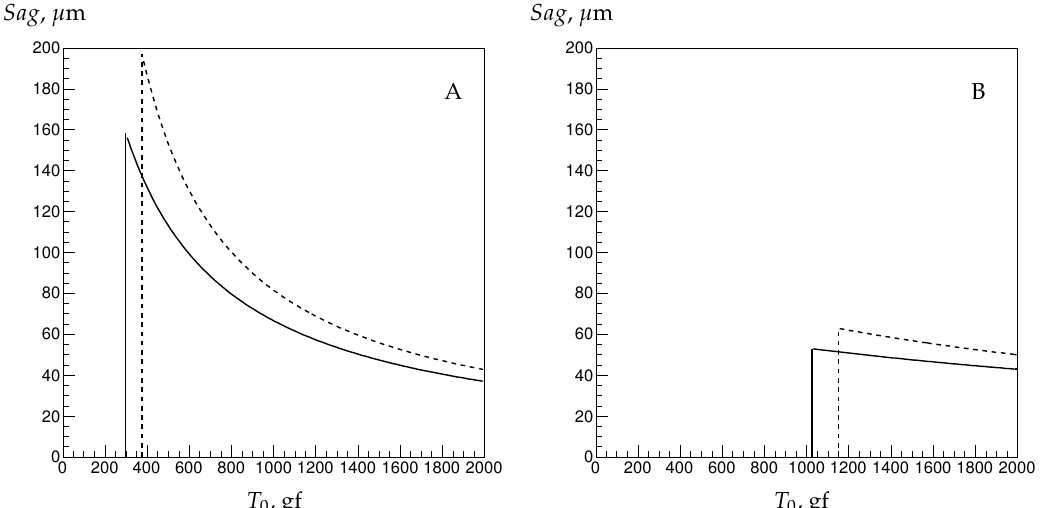
Figure 4. Sagitta in vacuum Sag versus pre-tension T 0 of 70-cm-long straw segment for: 9.8-mm straw ( A ); and 18-mm straw ( B ). Vertical lines mark the buckling limit T P = 0. Solid line is calculated for the central values for all parameters. Dashed lines show the worst case (see